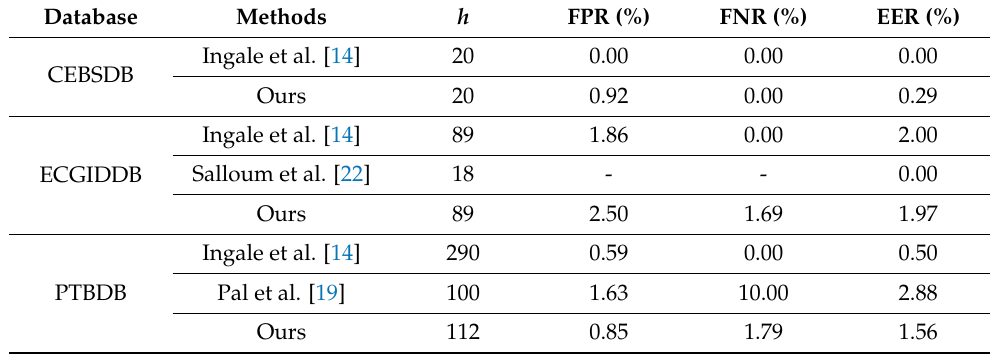
Table 12. Performance comparison of individual verification over short time separation.